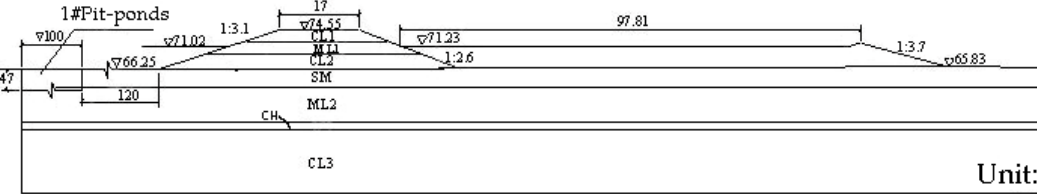
Figure 14. Typical profile map of the dike.